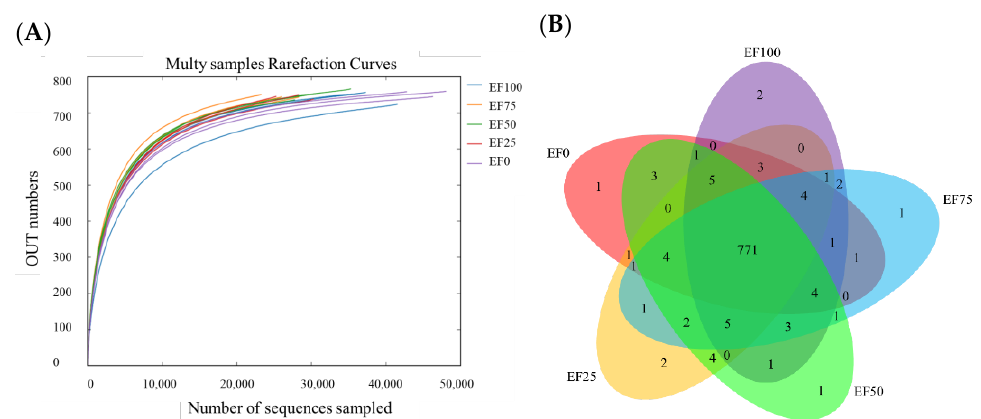
Figure 1. ( A ) The sample rarefaction curves and ( B ) Venn diagram showing overlap among the OTUs of the sheep rumen microbial communities with different addition levels of EF. EF0, EF25, FE50, EF75, and EF100 are defined as EF replacement ratios of 0%, 25%, 50%, 75%, and 100% of the fermentation substrate, respectively.